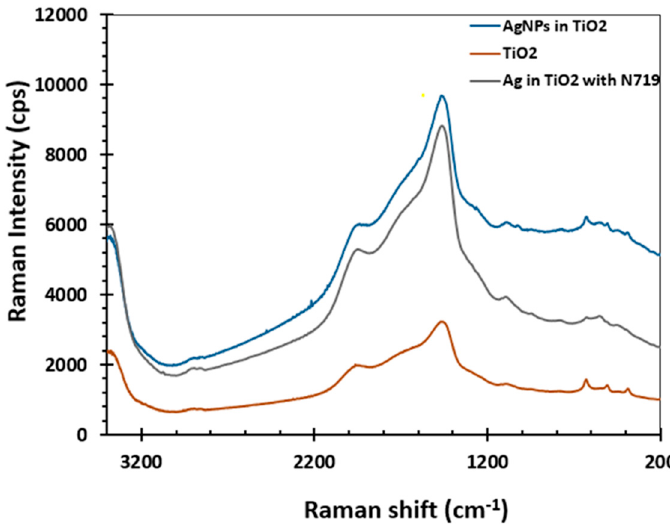
Figure 6. Raman spectra of Silver Nanoparticles (AgNPs) infused titanium dioxide and bare titanium dioxide .